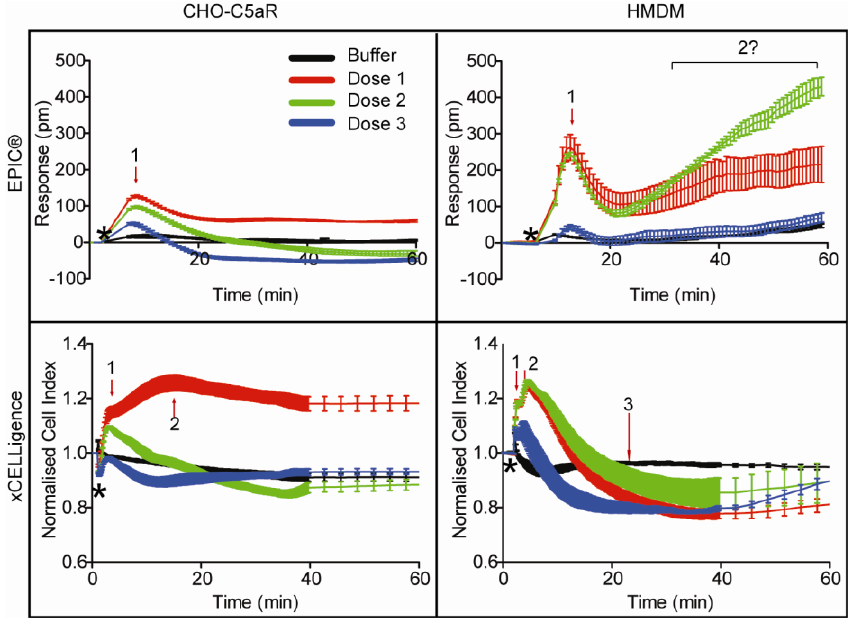
Figure 2. Three dose representative label-free profiles for C5a (red, blue and green) and baseline (black) in human monocyte-derived macrophages (HMDM) and CHO-C5aR cells on the EPIC ® and xCELLigence. The average of triplicates with SEM is shown. For CHO-C5aR cells, red is 250 nM, green is 83 nM and blue is 28 nM. For HMDM, red is 1 µM, green is 0.3 µM and blue is 0.1 µM. Arrows indicate peaks that may be indicative of different signalling pathways. Black star indicates point of compound addition. Question mark indicates ambiguous, but dose-dependent